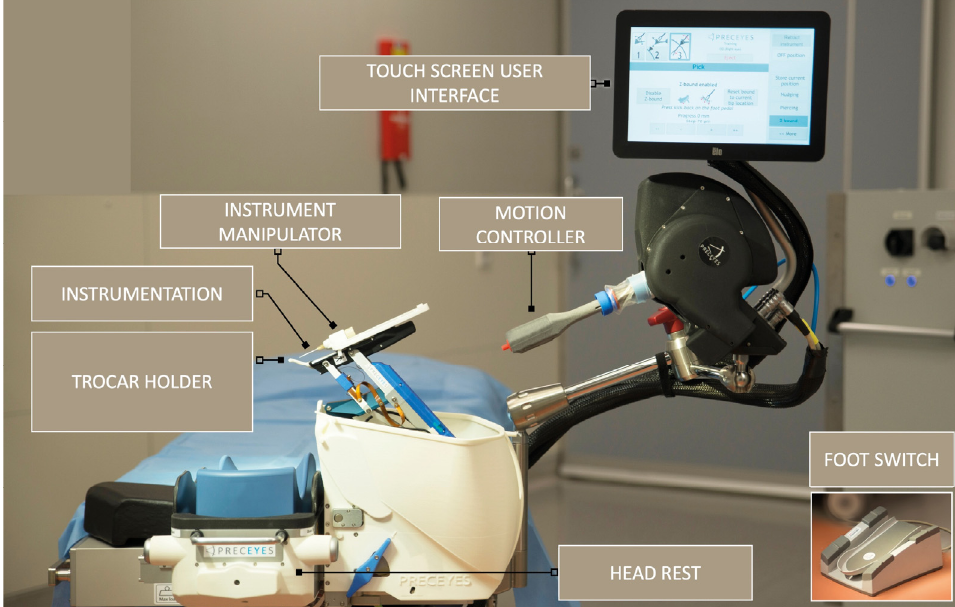
Figure 2. An overview of the Preceyes Surgical System (PSS). The system is based on a telemanipu- lation system: the motion controller is used as a joystick and translates rough movements into fine movements of the intraocular instrument. The instrument is attached to the instrument manipulator and enters the globe via a trocar. A touch screen is used to switch between different modules. The foot switch can be used to open and close the forceps pneumatically (image courtesy of Carl Zeiss Meditec AG, Jena, Germany).